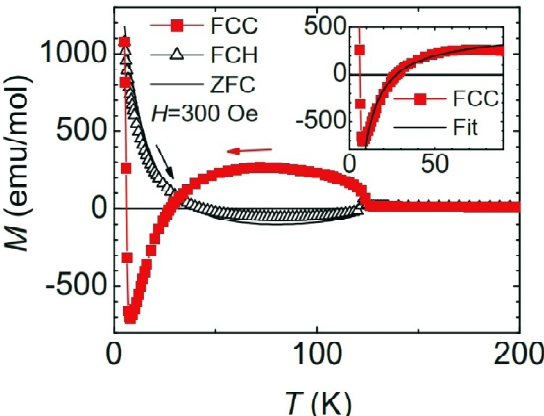
Fig. 3. Temperature dependent magnetization curves of TmCrO . The inset shows the Curie–Weiss 3 fit of the FCC data. Reproduced from [15] with per- mission from Springer.